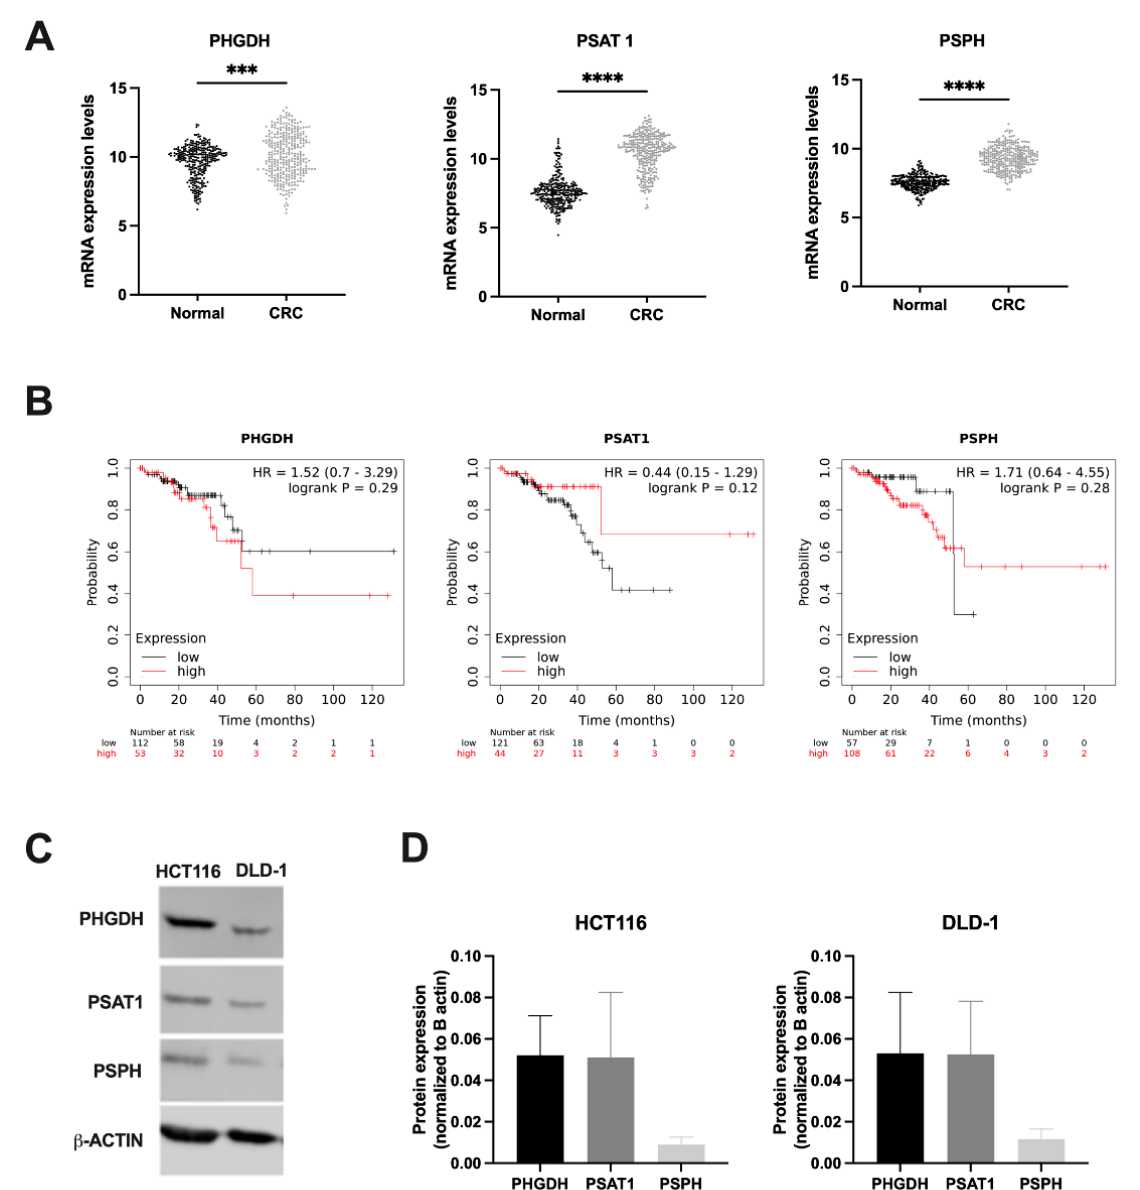
Figure 1. Serine synthesis pathway enzymes are expressed in human colorectal cancers. ( A ) PHGDH, PSAT1 and PSPH mRNA expression levels of GTEx normal tissues were compared to mRNA expression profile of CRC tumor tissues out of the TCGA database (RSEM values). ( B ) Kaplan–Meier curves showing overall survival in PHGDH, PSAT1 and PSPH low/high mRNA-expressing rectum cancer patients out of the TCGA database. ( C ) Representative Western blots of PHGDH, PSAT1 and PSPH with β -actin as loading control in HCT116 and DLD-1 cells under normoxic conditions. ( D ) Relative expression of PHGDH, PSAT1 and PSPH normalized to β -actin in HCT116 and DLD-1 cells under normoxic conditions. Data are shown from at least three replicates as mean ± SEM. Unpaired t -test with Mann–Whitney test was used for statistical analysis: *** p < 0.001, **** p < 0.0001.